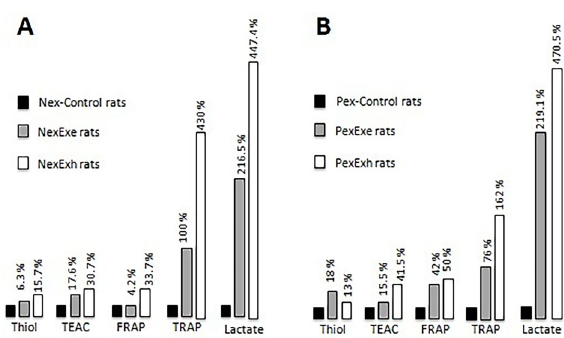
Figure 6. Summary of the antioxidant capacity experiments. A , Never exposed (Nex) group. B , Pre-exposed (Pex) group. Percent increase in thiol, TEAC, FRAP, TRAP, and lactate levels after exercise (Exe rats: gray bars) and exhaustion (Exh rats: white bars) compared with control groups (black bars). The increase in plasma lactate (Control rats vs Exe or Exh rats) was more pronounced than thiol, TEAC, FRAP, and TRAP levels in the Nex or Pex groups, thus, suggesting a potential role for lactate as an antioxidant after strenuous exercise and exhaustion. Thiol: protein sulfhydryl group content; TEAC: trolox equivalents antioxidant capacity; FRAP: ferric reducing ability of plasma; TRAP: total radical-trapping antioxidant